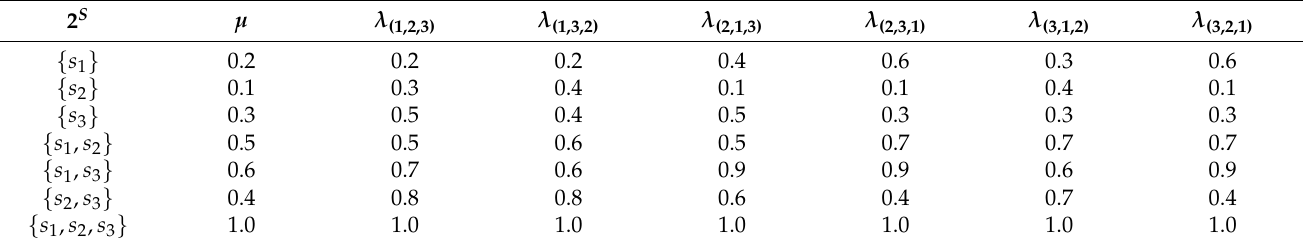
Table 2. Fuzzy measure µ on S and its associated probabilities. { λ σ } , σ = ( σ ( 1 ) , σ ( 2 ) , σ ( 3 )) ∈ S 3